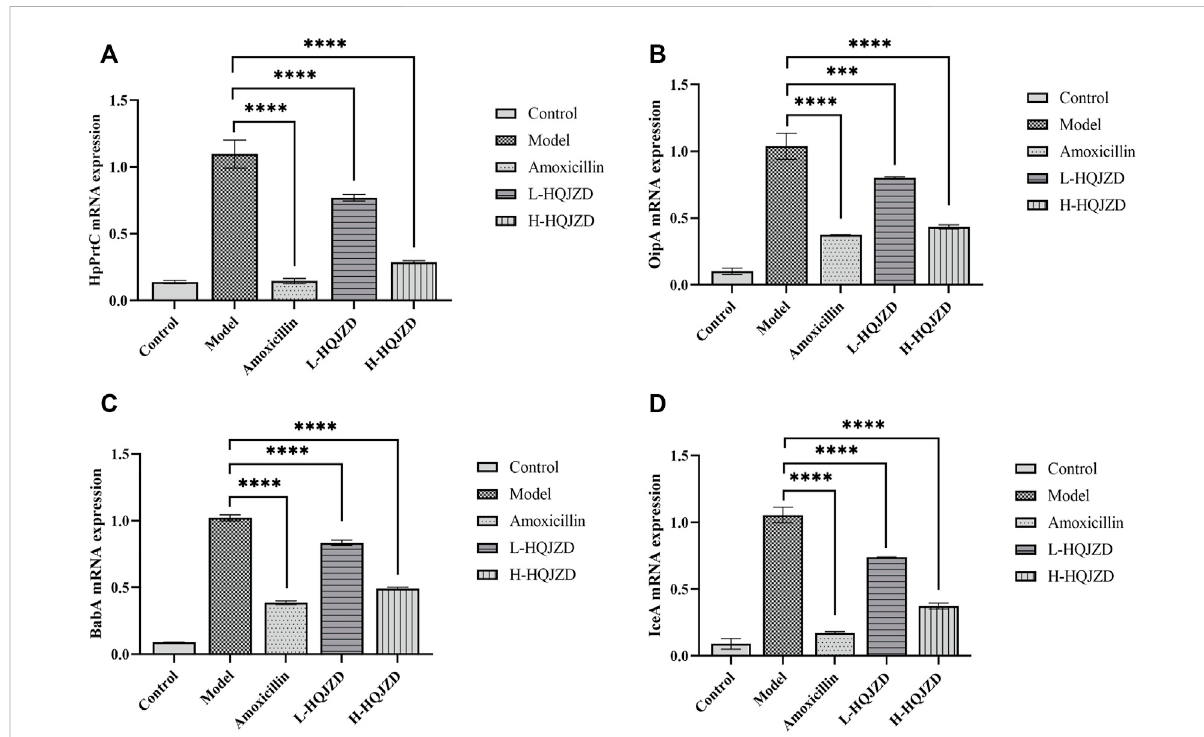
FIGURE 3 Effect of HQJZD on the expression of HpPrtC, OPiA, IceA1, and BabA2 mRNA in GES-1 cells infected with H. pylori . (A) mRNA expression of HpPrtC; (B) mRNA expression of OPiA; (C) mRNA expression of BabA2; and (D) mRNA expression of